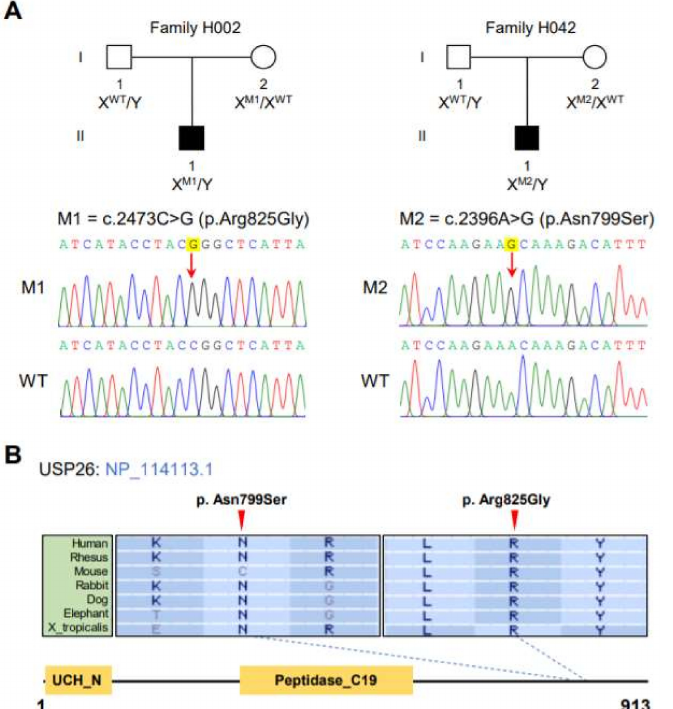
Figure 1. Identification of hemizygous variants of X-linked USP26 in men with asthenoteratozoosper- mia. ( A ) Pedigrees of two families affected by hemizygous USP26 variants. Black-filled squares indicate the male individuals with asthenoteratozoospermia. Sanger sequencing results are shown below the pedigrees. The variant positions are indicated by red arrows. WT, wild type. ( B ) Variant locations and phylogenetic conservation of the mutated residues in the USP26 protein. The NCBI reference sequence number for the USP26 protein is NP_114113.1. The orange boxes indicate different domains, as described by the NCBI browser. The UCH_N, N-terminal of ubiquitin carboxyl-terminal